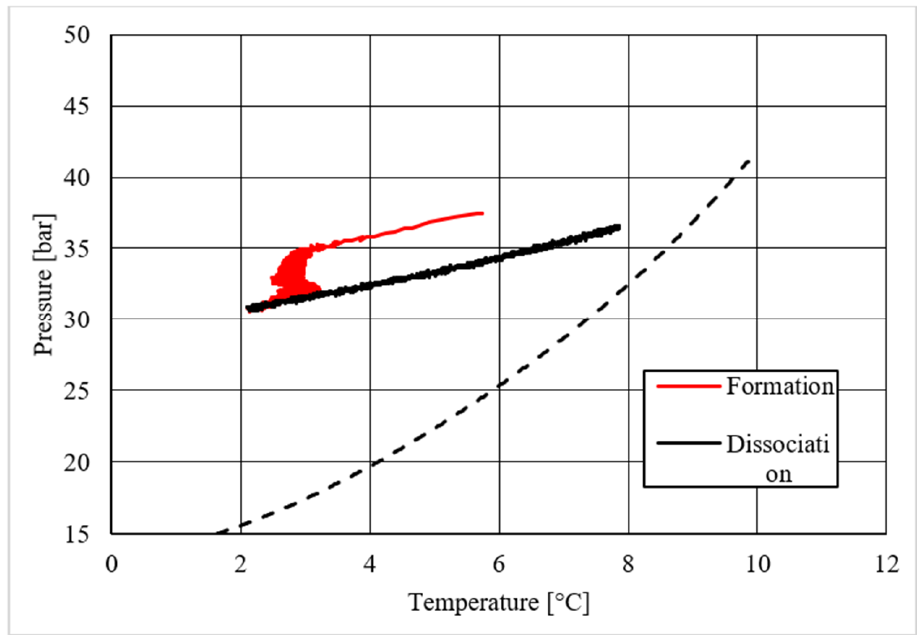
Figure 17. Pressure vs. temperature, describing carbon dioxide hydrate formation in the presence of 4.23 wt.% CuSn12 powder.